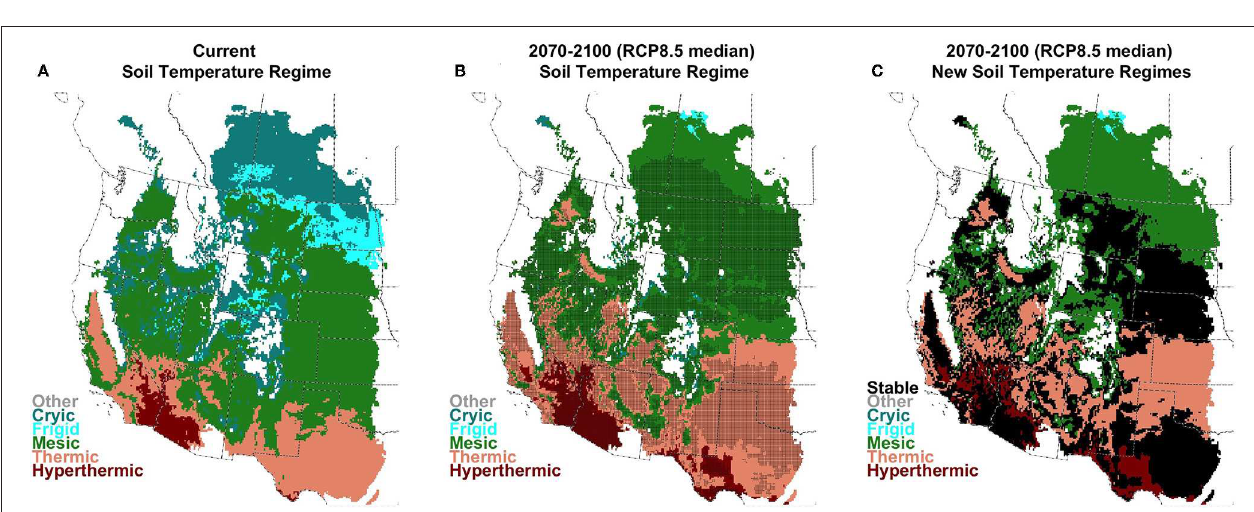
( Figure S1.5 ), with slightly larger magnitudes and stronger geographic patterns than T ANN50 . These temperature increases supported substantial shifts in the geographic distribution of soil temperature regimes ( Figure 4 and Figure S1.6 ). The extent of cooler Cryic and Frigid regimes, currently representing 31% of the region, were projected to represent only 19% in the near- term for RCP8.5 (21% for RCP4.5), and < 2% in the long-term for RCP8.5 (14% for RCP4.5). Thermic and Hyperthermic regimes, currently found only in the southern portion of the region, expanded from 21% of the region to 28% in the near-term for RCP8.5 (27% for RCP 4.5) and 41% in the long-term (32% for RCP4.5). Mesic soil temperatures increased modestly, from 48% of the region currently to 53% in the near-term (52% for RCP4.5) and 58% in the long-term (54% for RCP4.5). Especially for RCP8.5 and the long-term, Thermic and Hyperthermic